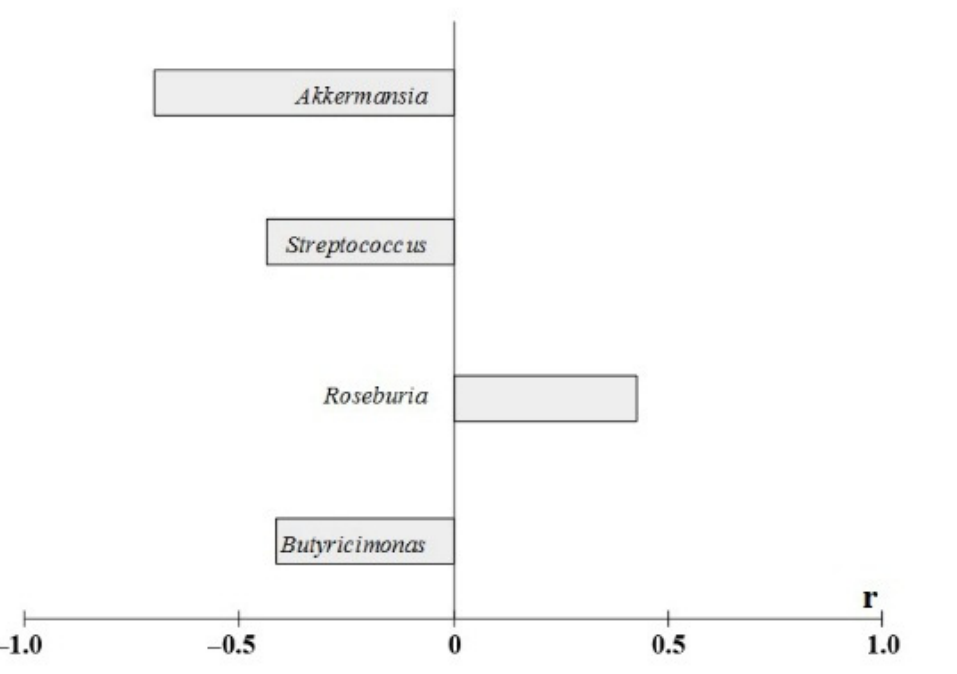
Figure 12. Coefficients of correlation between relative abundances bacterial taxa in the intestinal microbiome and myocardial infarction size at the end of the experiment. Notes: total data for all animals, the results of the study are presented using p < 0.05. A search for correlations between the studied parameters was performed using Spearman’s test.